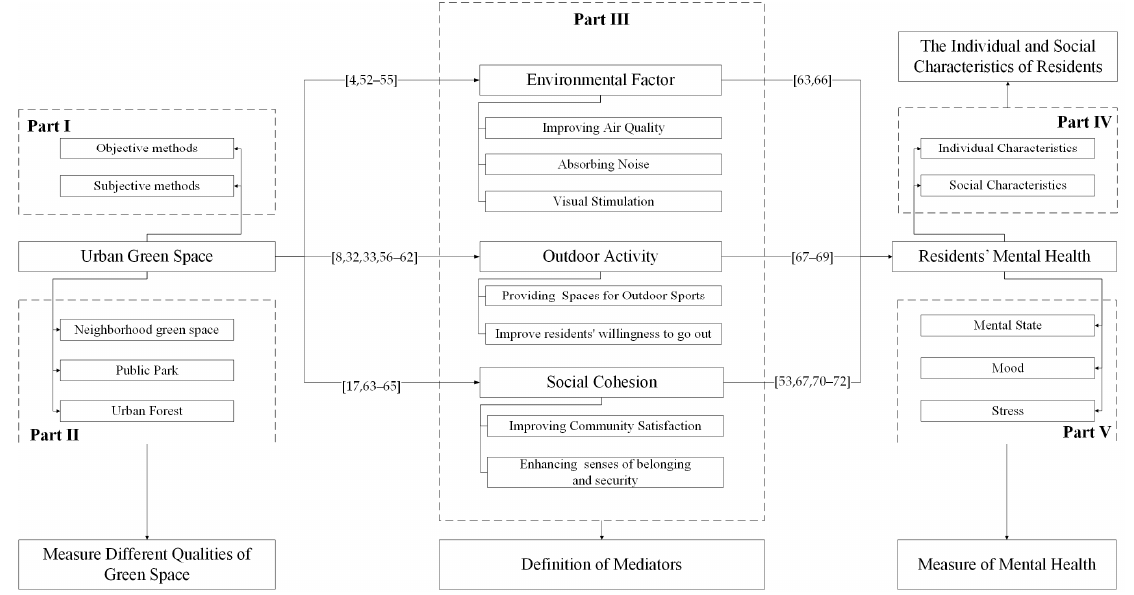
Figure 2. The mediators and influencing paths of urban green space’s impact on residents’ mental health [4,8,17,32,33,44,51–72]. Notes: (1) Part I and Part II are the classification and measurement of urban green space, respectively, which is defined in Section 2. (2) Part III is the mediators of urban green space’s impact on residents’ mental health, which is the core part of the article. This part will be shown in Section 3.1. (3) Part IV is the heterogeneity characteristics of residents. The heterogenous effect of different mediators on various groups is shown in Section 3.2. (4) Part V is the measurement of mental health, which is presented in Appendix A. (5) Based on part III, the classification and definition of mediators is discussed in Section 4.1. (6) Based on part IV, the individual and group characteristics of residents are discussed in Section 4.2. (7) Based on parts I and II, the classification study and quality analysis of green space will be discussed in Section 4.3. (8) Based on parts III and V, measures of mental health are discussed in Section 4.4 in terms of